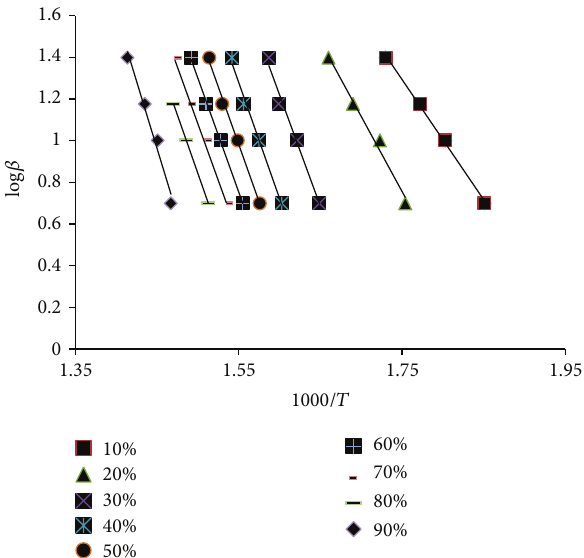
Figure 9: Ozawa plots of the logarithm of the heating rate (𝛽) versus the reciprocal temperature ( 1000/𝑇 ) at different conversions for